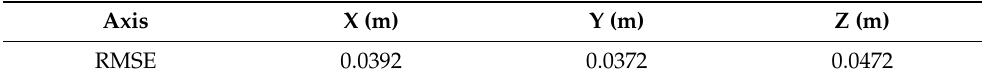
Table 3. RMSE of target tracking in experiment 3.